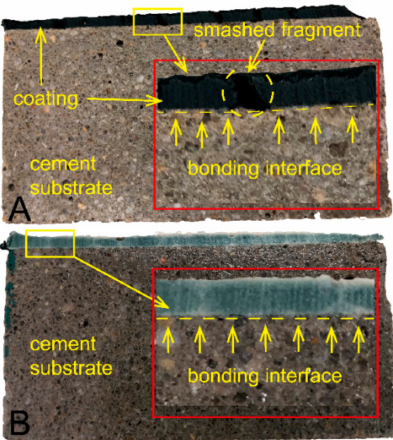
Figure 5. Adhesive characteristics between AAM coating and cement mortar substrate, ( A ) sample 1#; ( B ) sample 3#.